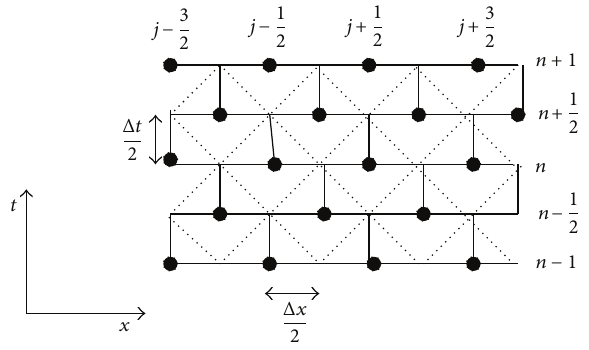
Figure 1: Mesh discretization for the CE-SE